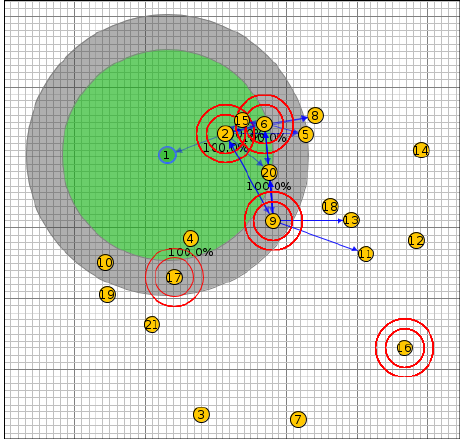
Figure 7. Scenario I with 20 nodes.